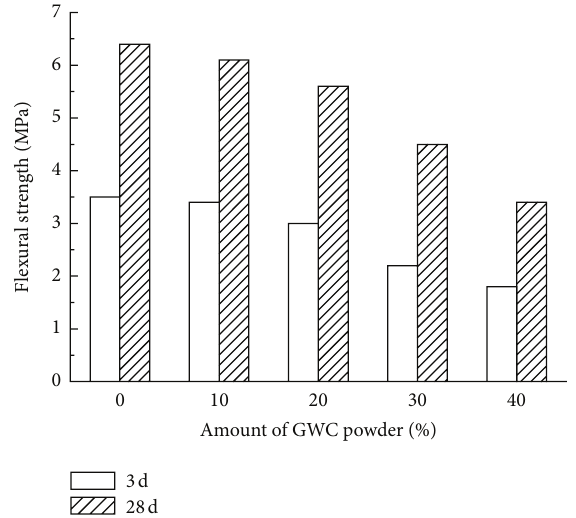
Figure 4: Flexural strength of mortar with different amounts of GWC powder.